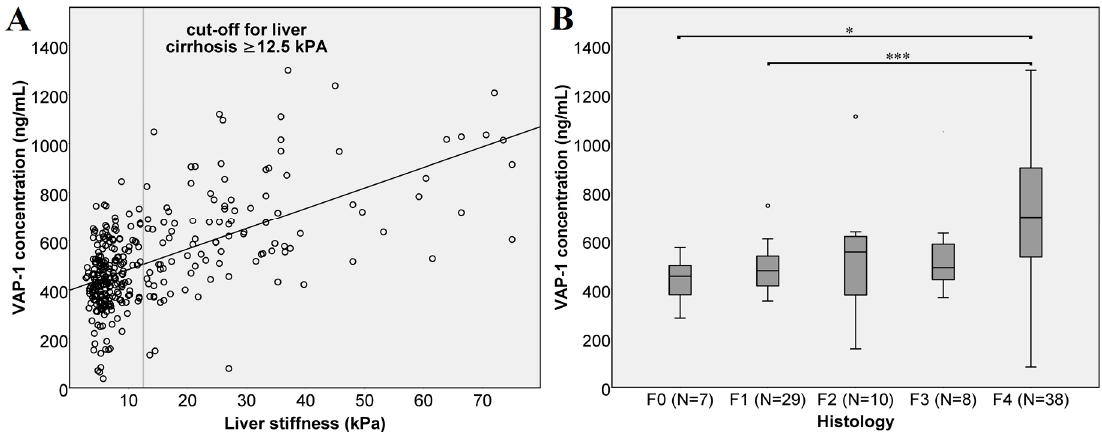
Figure 1. Vascular adhesion protein ‐ 1 (VAP ‐ 1) concentration and liver fibrosis. ( A ) VAP ‐ 1 concentration and liver stiffness of all 322 patients. The cut ‐ off value for liver cirrhosis was set at >12.5 kPa. The line shows the trend of the VAP ‐ 1 concentration with increasing liver stiffness as assessed by transient elastography. ( B ) VAP ‐ 1 concentration in different fibrosis stages as assessed by biopsy ‐ based histology. According to the Kruskal–Wallis test, there were no significant differences ( p > 0.05) between different biopsy ‐ based fibrosis stages (F0 vs. F1, F2 or F3; F1 vs. F2 or F3 and F2 vs. F3). There were significant differences between F0 vs. F4 ( p = 0.012) and highly significant between F1 vs. F4 ( p < 0.001). Significance is shown as * p < 0.05, and *** p < 0.001. The VAP ‐ 1 concentration also significantly correlated with glutamate pyruvate transaminase (GPT), GOT, GOT/GPT ratio, GGT, cholesterol, bilirubin, albumin, platelets and age (Table 2). The SSAO activity showed a lower but significant, correlation with these parameters.